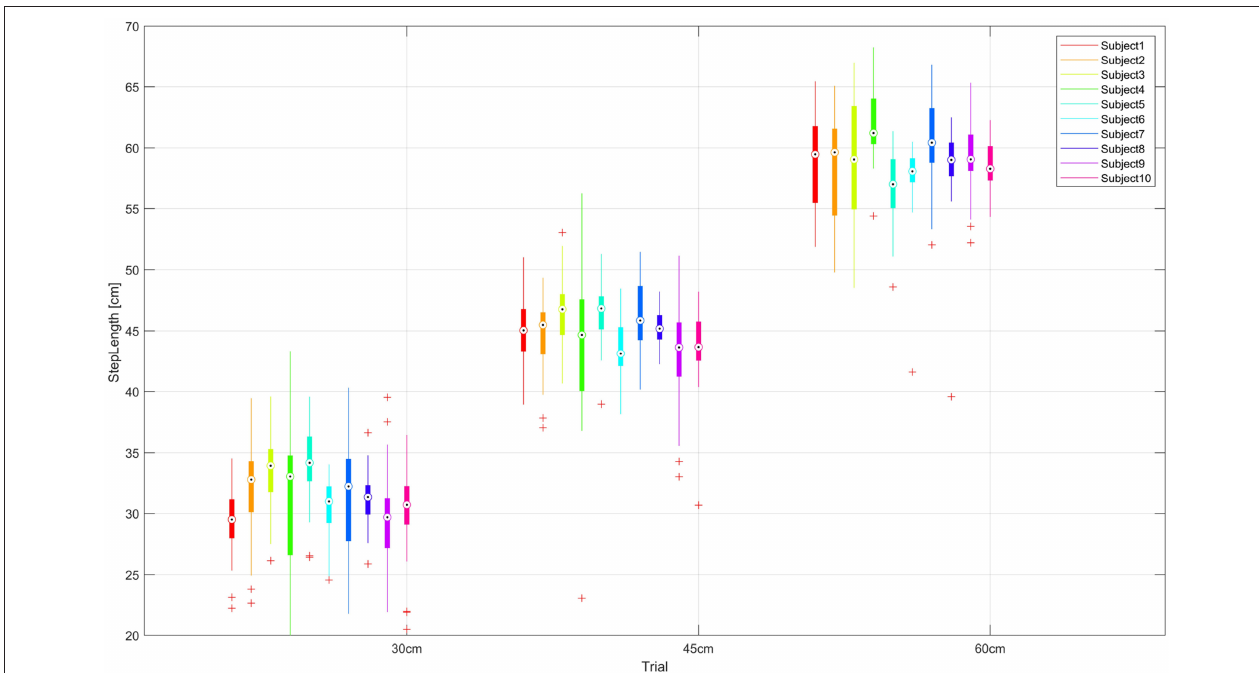
FIGURE 5 | SL values are shown for each subject grouped per test. The median (dot), first and third quartiles (box), minimum and maximum values (lines) and some outliers (plus sign) are displayed. As expected, restricted SL trials appear close to each other across subjects, trials 1, 2, and 3.